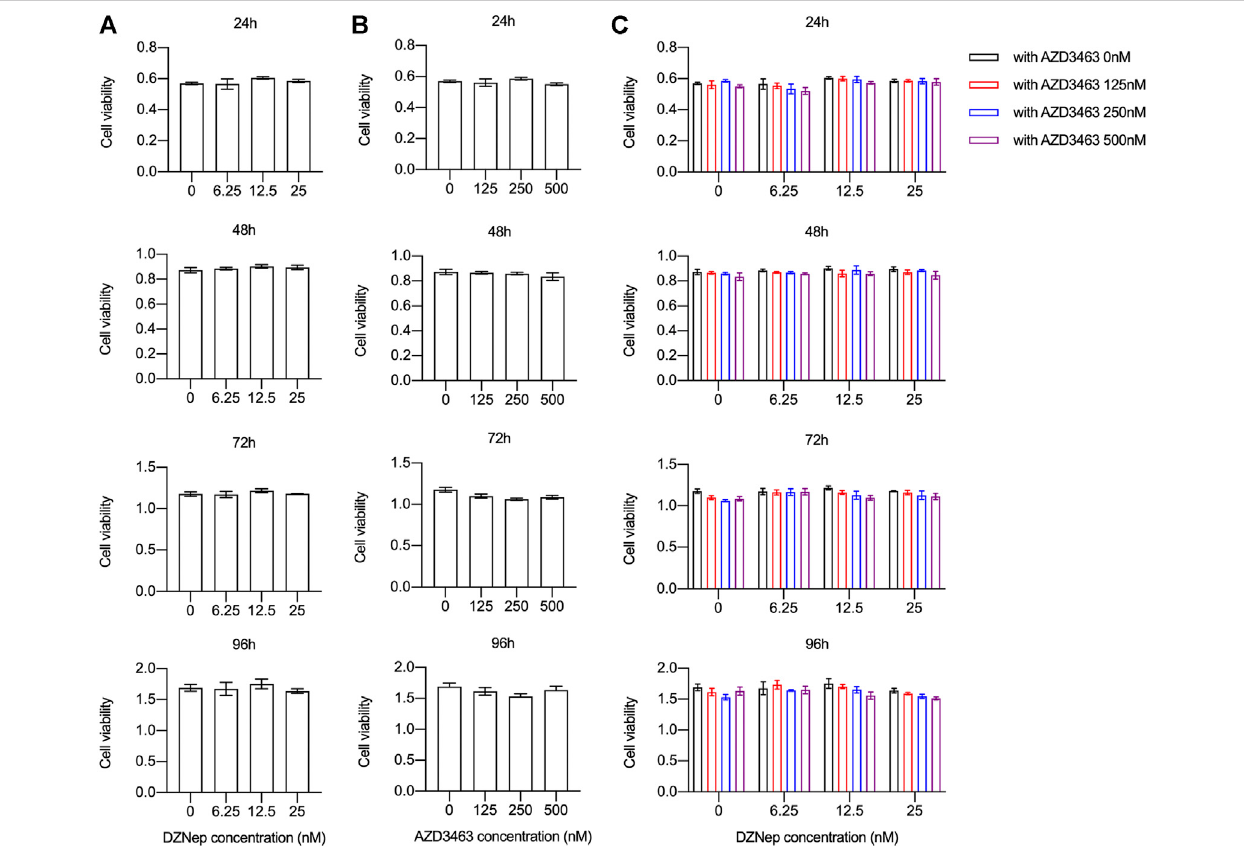
FIGURE 1 | DZNep and AZD3463 did not affect BMM proliferation in vitro . BMM viability and proliferation remained stable after treatment with (A) DZNep (6.25, 12.5,and25 nM)for24,48,72,and96 h, (B) AZD3463(125,250,and500 nM)for24,48,72,and96 h,and (C) DZNep(6.25,12,and25 nM)plusAZD3463(125,250, and 500 nM) for 24, 48, 72, and 96